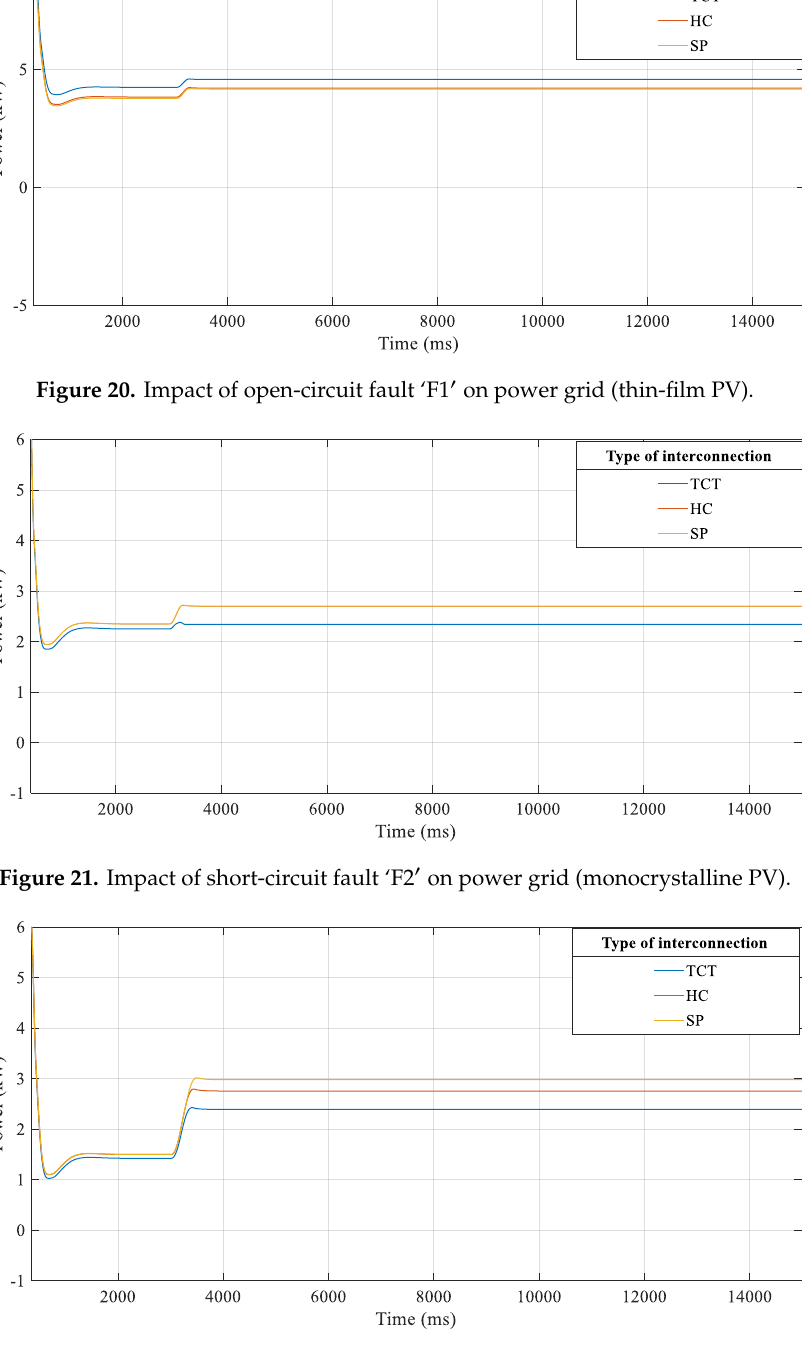
Figure 22. Impact of short- circuit fault ‘F2′ on power grid (thin-film PV).